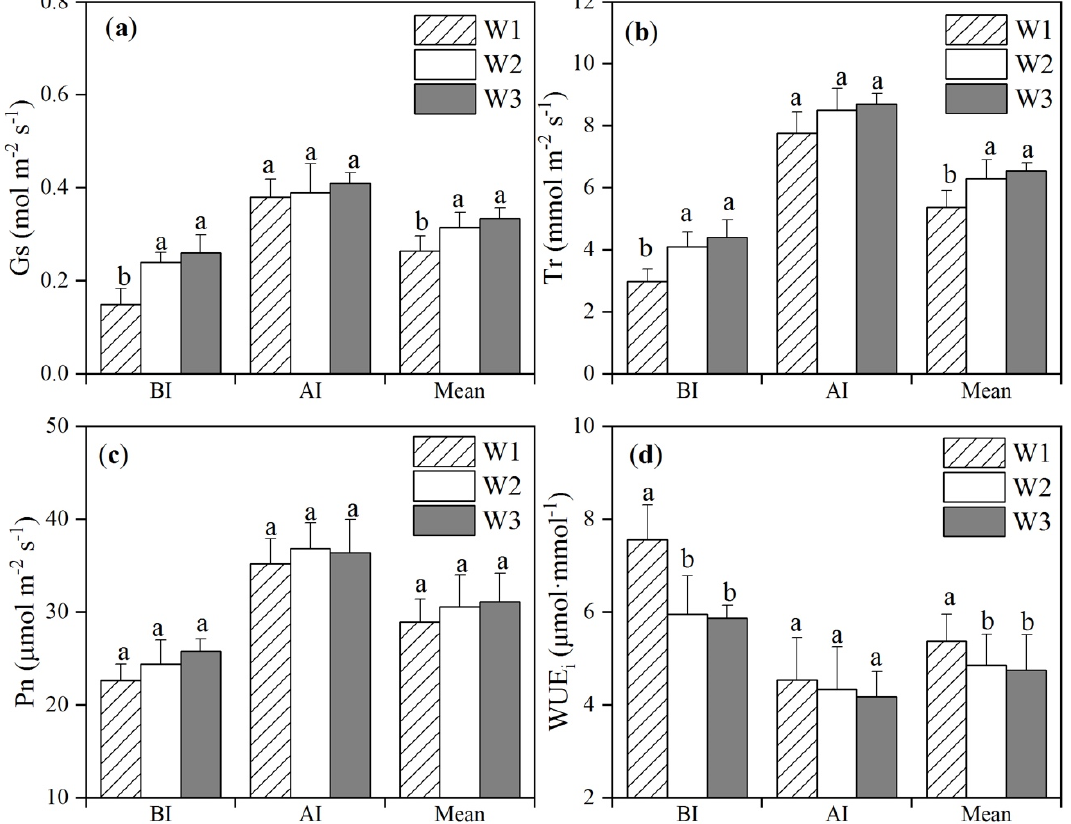
Figure 5. Stomatal conductance (Gs) ( a ), transpiration rate (Tr) ( b ), net photosynthesis rate (Pn) ( c ) and intrinsic water use efficiency (WUE i ) ( d ) of spring maize before (BI) and after (AI) irrigation in 2016. Mean values indicate the average values from BI and AI. W1, W2 and W3 are the treatments with different D h (designed wetting depth). D h values in W1, W2 and W3 are 0–40 cm, 0–50 cm and 0–60 cm, respectively. Vertical bars represent standard errors. Different letters above bar plot indicate that there are significant differences in Pn/Tr/Gs among treatments at P < 0.05.